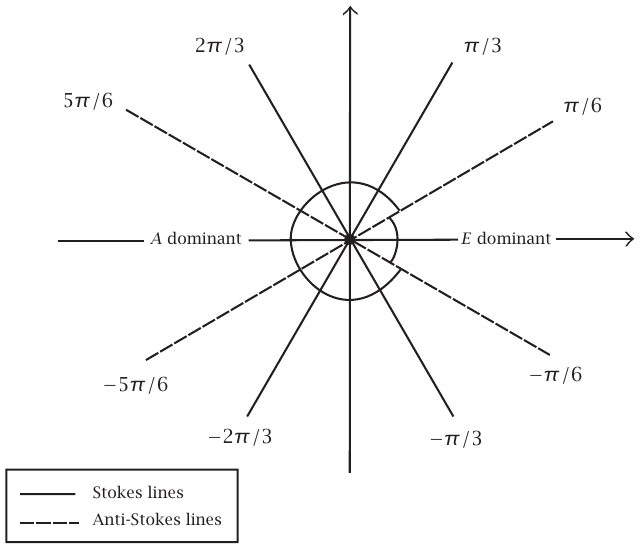
Figure 2.2 . The Stokes lines are shown for the exponential term in (2.19a) corresponding to µ = 1 / 3. Also shown is the sector E where the exponential term in (2.19a) dominates and the sector A where the algebraic term in (2.19) dominates.